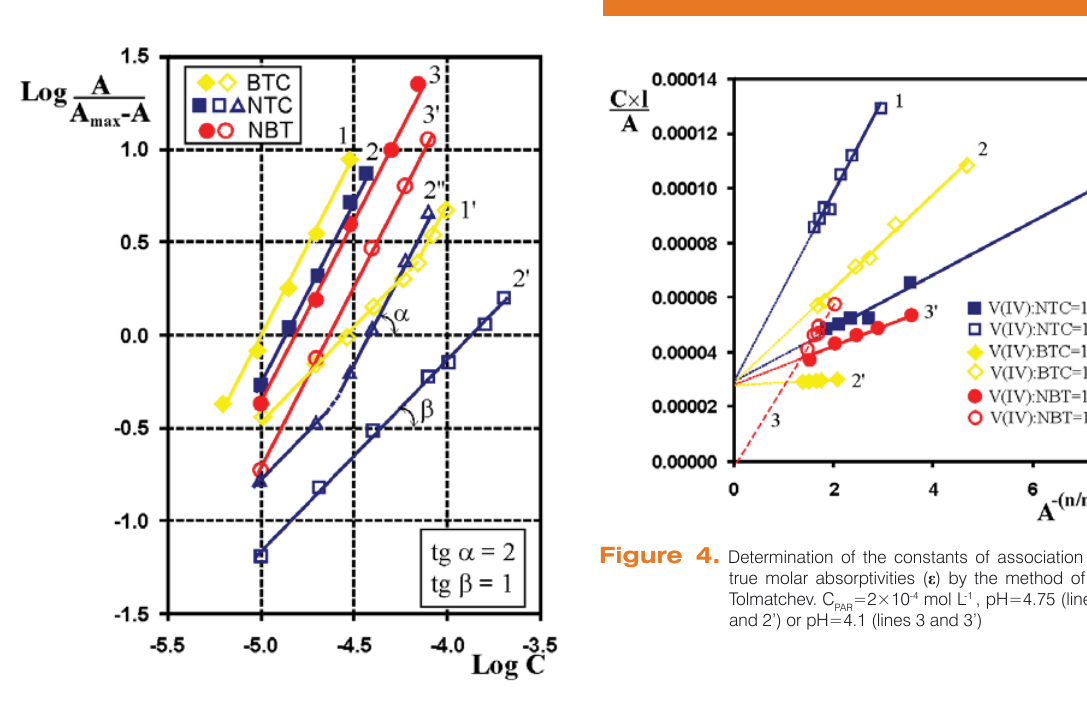
Figure 3. Determination of the PAR-to-V(IV) (1-3) and DTC-to-V(IV) (1’,2’,2”,3’) molar ratios by the Equilibrium shift method. C =2×10 −5 mol L -1 , V(IV) pH=4.75 (1,1’,2,2”) or 4.1 (2’,3,3’), l=0.5 cm